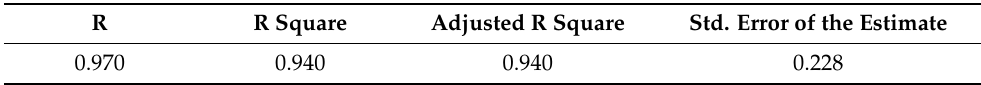
Table A1. Model Summary